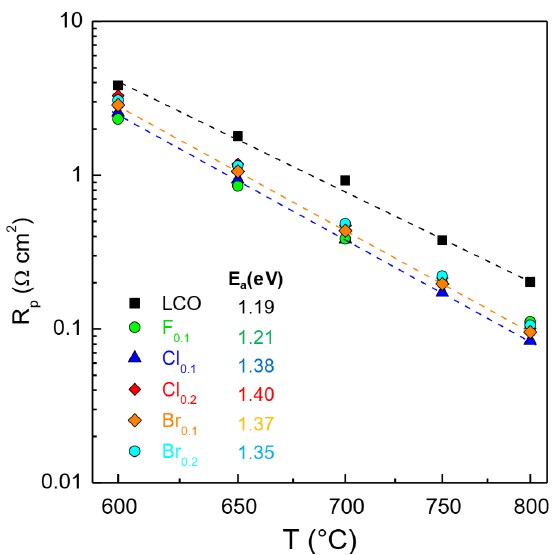
Figure 10. Variation of the total polarization resistance with the temperature of La 2 CuO 4 − 0.5x A x (A = F, Cl, Br; x = 0–0.2)